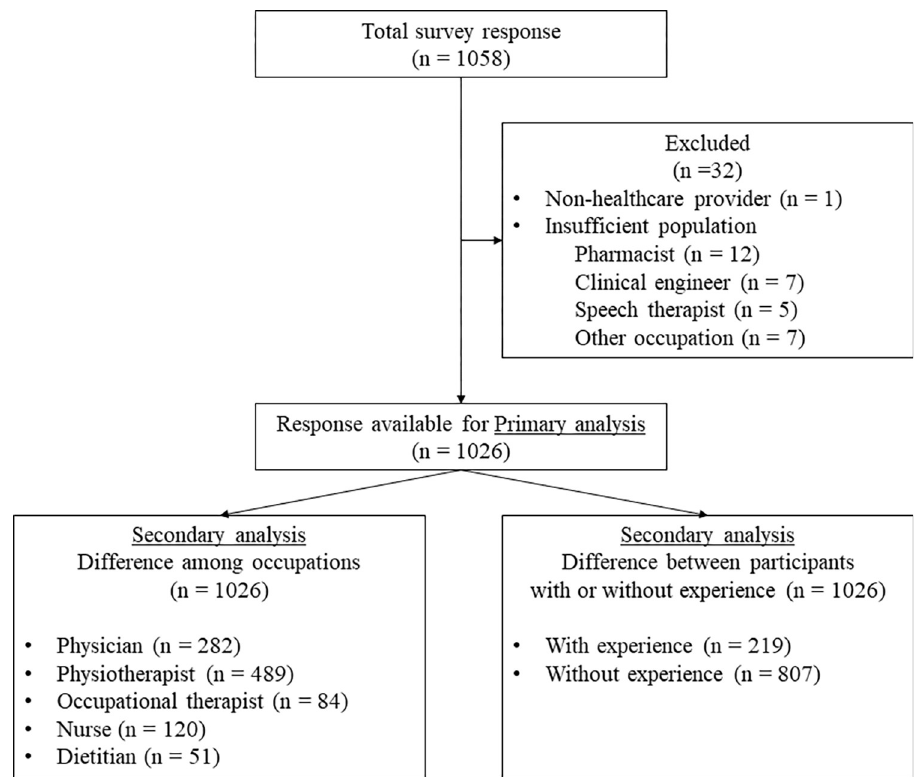
Fig 1. Flow of participants through the study. Among 1,058 respondents, 1,026 were included in the primary analysis. Secondary outcomes included the differences based on occupation and the differences in ultrasound-based muscle mass assessment between experienced and inexperienced